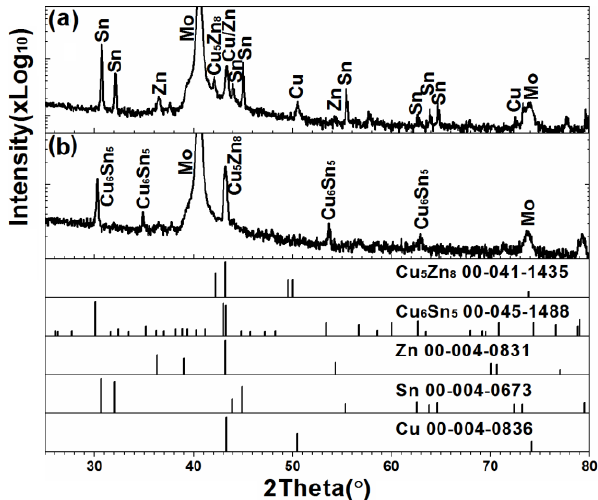
Figure 2. The X-ray diffraction (XRD) patterns of the electrodeposited CuSnZn precursor ( a ) before; and ( b ) after annealing at 300 °C for 30 min.